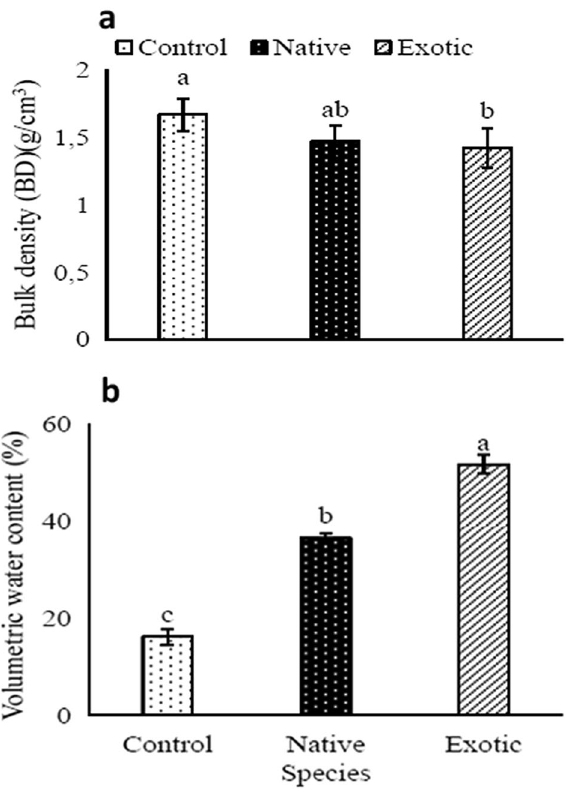
Figure 6. The effects of two different Tamarix species on soil bulk density and volumetric water content compared to the controls: ( a ) Soil bulk density and ( b ) soil volumetric water content. Means followed by different letters are significantly different from each other (Turkey’s test HSD). Bars indicate standard